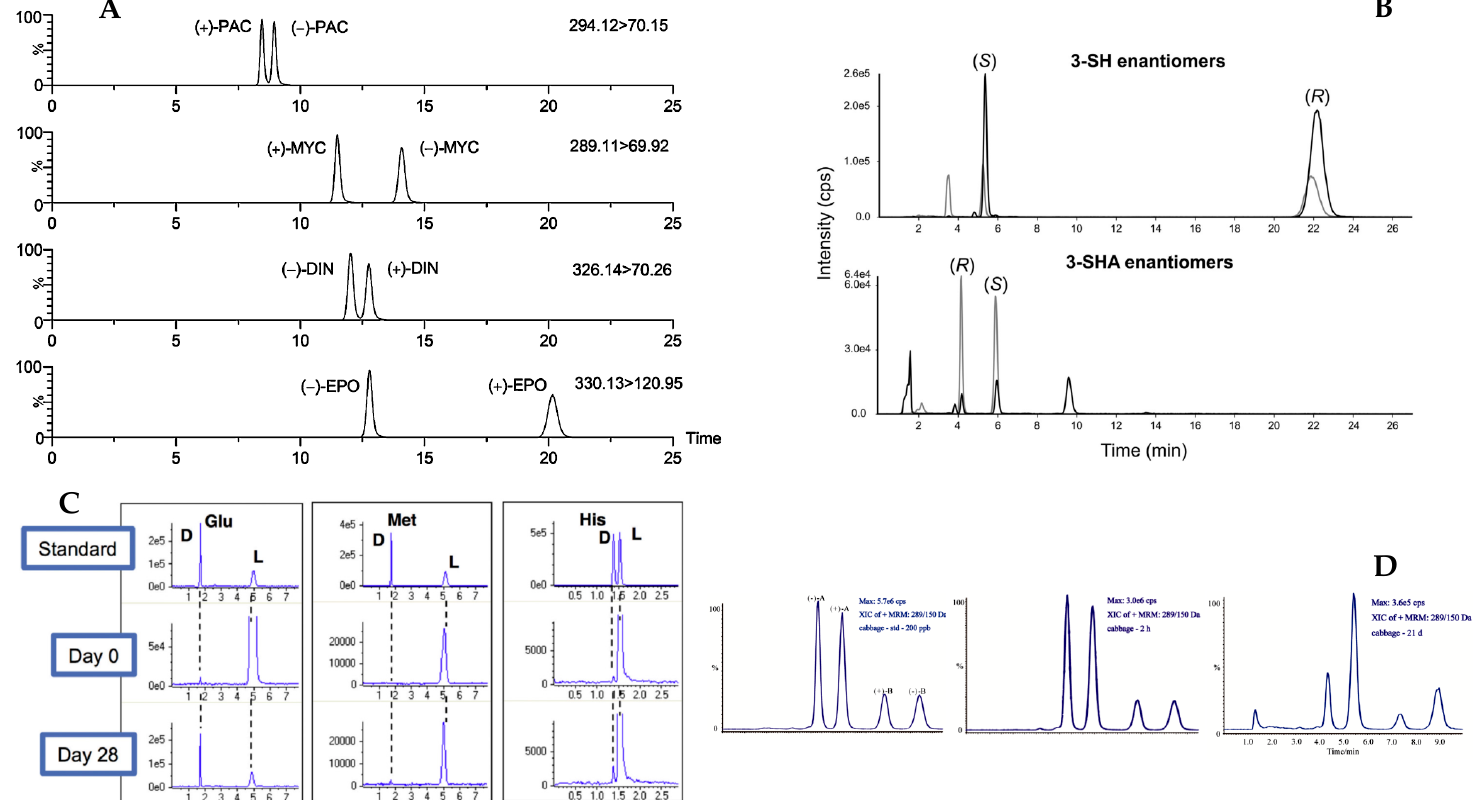
Figure 3. Typical enantioselective LC–MS/MS chromatograms: ( A ) chiral triazole fungicides in blank honey spiked using a Chiralcel OD-RH column modified with permission from [57]; ( B ) 3-sulfanylhexan-1-ol (3-SH 1) and 3-sulfanylhexyl acetate (3-SHA 2) isolated from a Sauvignon blanc wine on a CSP -Amylose-1 column; modified with permission from [48]. ( C ) Enantiomers resolution of some amino acids in kimchi stored for 25/28 days analyzed on a CSP- CROWNPAK CR-I by LC-TOF; modified with permission from [55]; and ( D ) Enatiomeric separation of fungicide pyrisoxazole by LC-MS on a CSP- Lux Cellulose-3; modified with permission from Reference [45].